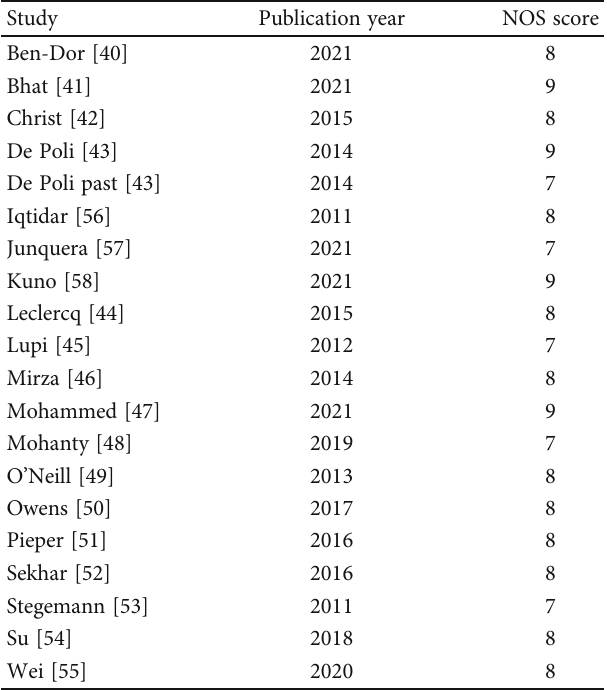
RCT= randomized controlled trial; NOS= Newcastle-Ottawa